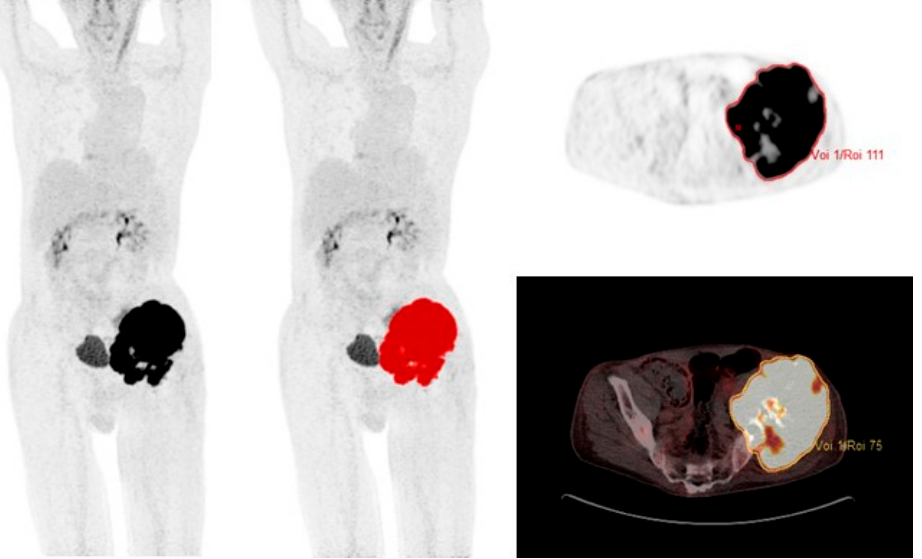
Figure 1. 69-year-old male with localized chondrosarcoma and an open VOI covering the entire tumor with SUV >2.5